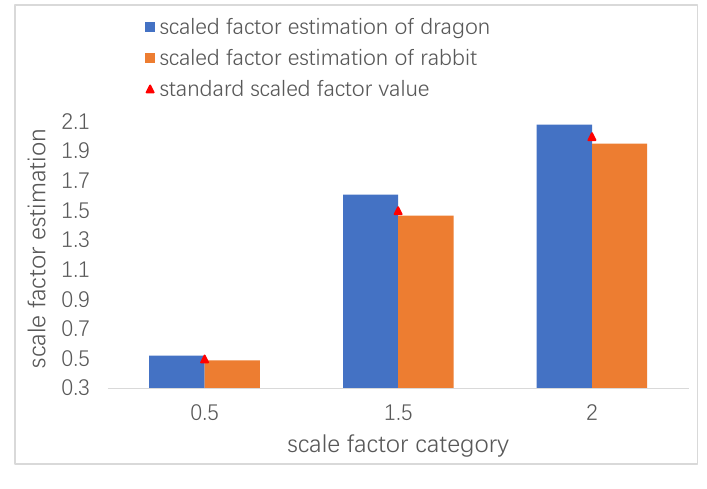
Figure 14. The comparison of scale estimation value for different scale factors. Figure 14 records scale factor estimation value of dragon and bunny rabbit data sets with different scale factors. The x-axis represents the scale factor category, the y-axis rep- resents the scale estimation value, the blue bar indicates the scale factor estimation value of the dragon data set, the orange bar indicates the scale factor estimation value of the bunny rabbit object, and the red triangle shows the real scale factor value. For scale factor 0.5, the estimation value for dragon and bunny rabbit is 0.520670 (+4.13% error) and 0.488558 ( − 2.23% error). For scale factor 1.5, the estimation value for dragon and bunny rabbit is 1.61036 (+7.36% error) and 1.46719 ( − 2.19% error). For scale factor 2, the estima- tion value of dragon and bunny rabbit is 2.08243 (+4.12% error) and 1.95423 ( − 2.29% error). The average error of our scale-estimation value for dragon and bunny rabbit is − 2.24% and +5.2%. Table 4. The RMSE results of different coarse-to-fine registration algorithms with TT strategy under multiple scale factors.